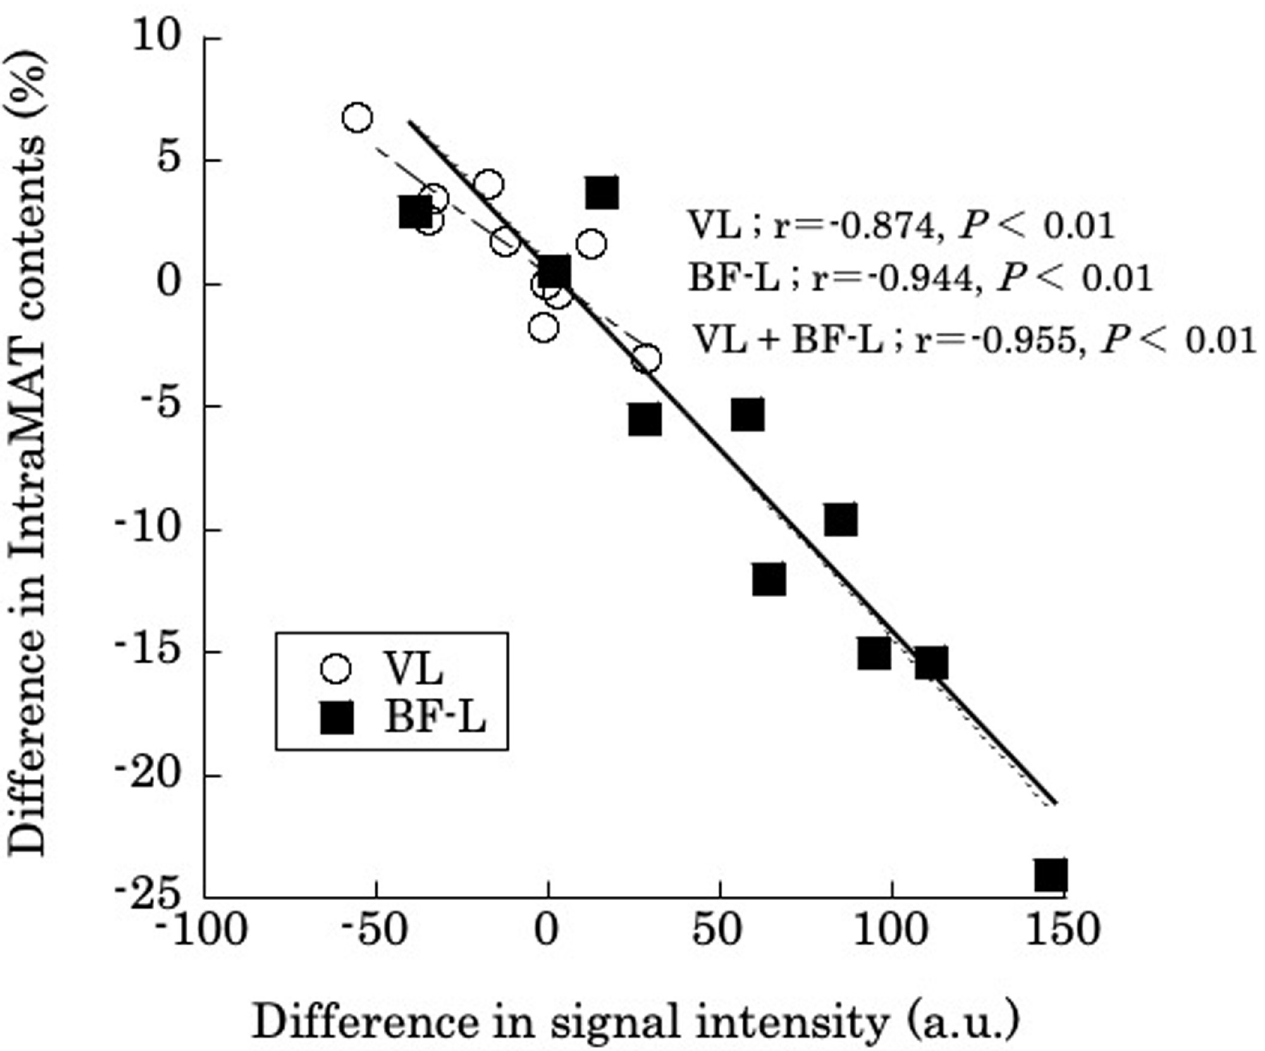
Fig 6. Correlation for intramuscular adipose tissue content (IntraMAT content; %) between T1-Weighted (T1W) and 2-Point Dixon (2PD) images, and differences in the 2PD boundary value and T1W threshold for the Vastus Lateralis (VL) and the Biceps Femoris-Long head (BF-L).